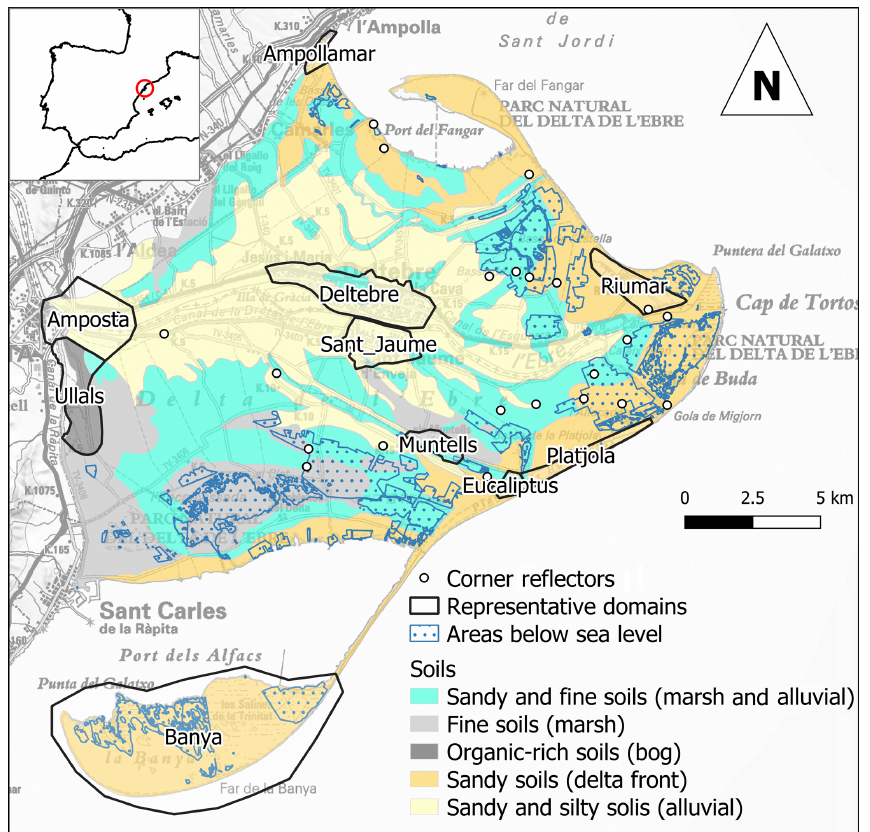
Figure 1. Map of the Ebro delta plain including soils distribution derived from the Soil map of Catalonia 1:25000 (deposit type in paren- thesis), corner reflectors location, selected domains and areas below the sea level. This figure uses a proprietary © ICGC base